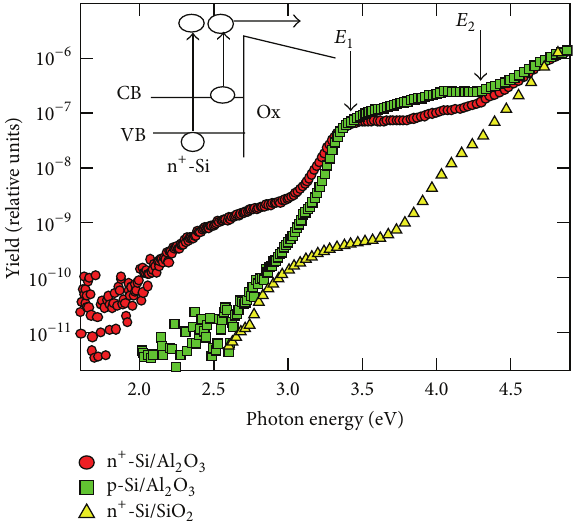
Figure 3: Semilogarithmic plots of the photocurrent yield as measured on p-Si(100)/Al 2 O 3 /Au ( ◻ ) and n + -Si(100)/Al 2 O 3 /Au ( I ) capacitors biased to an average strength of electric field in the oxide of 2 MV/cm. The insulating layer was fabricated by ALD of alumina at 300 ∘ C. For comparison, also shown is the yield spectrum measured on a n + -Si(100)/SiO 2 /Au sample for the oxide field strength of 1.57 MV/cm ( △ ). The inset schematically illustrates the observed electron IPE from the CB and VB of silicon.